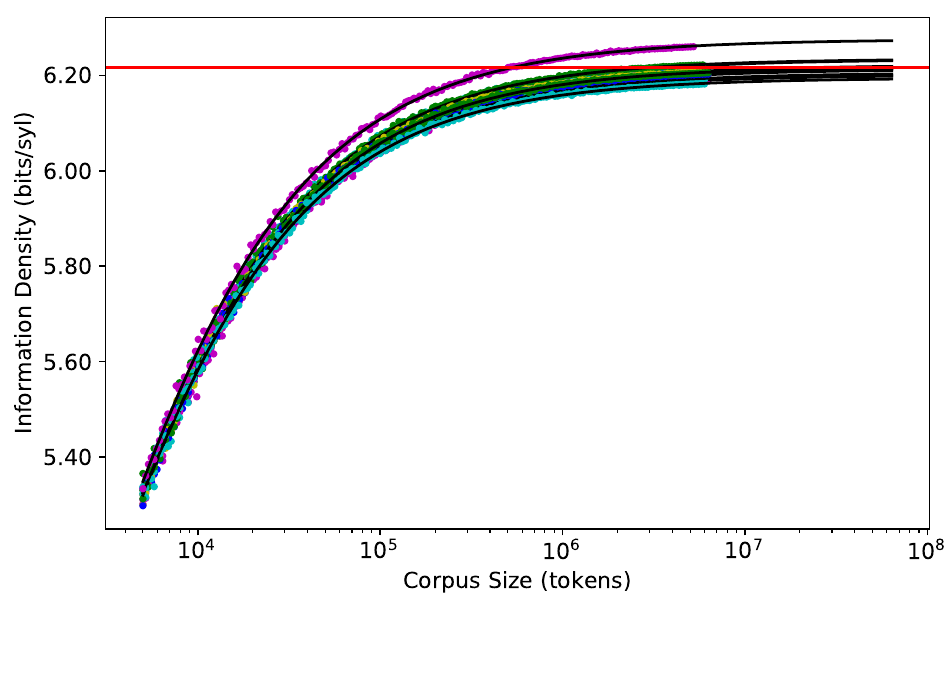
Figure 5. Results of author jackknifing. The visible outlier (in purple) is the corpus without Ci-